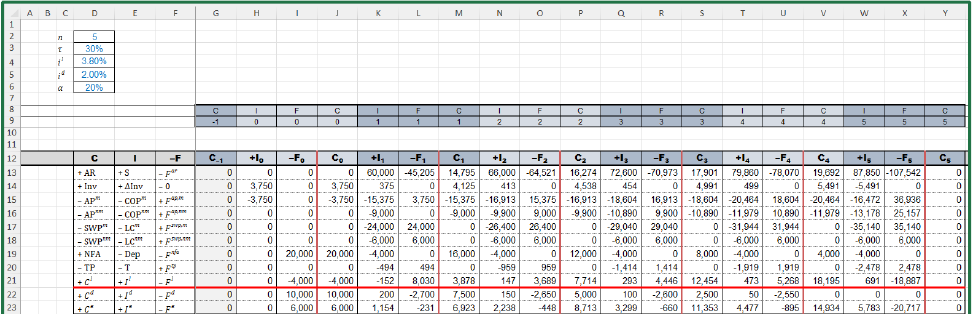
Figure 23. Full-scale project strip with all the figures (“SplitScreenStrip”